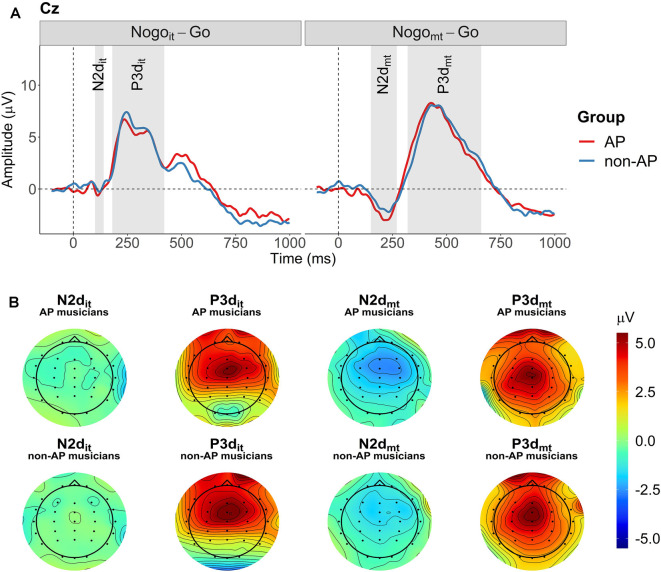
Grand averages and topographies of the difference waves (Nogoit minus Go, Nogomt minus Go). (A) Grand averages of the two difference waves are shown separately for the two groups at electrode Cz (red: AP musicians, blue: non-AP musicians). Time windows used for the computation of mean amplitudes are indicated by the gray-shaded areas. (B) Topographies for the four ERP components of interest (N2dit, P3dit, N2dmt, and P3dmt) are shown separately for AP and non-AP musicians.